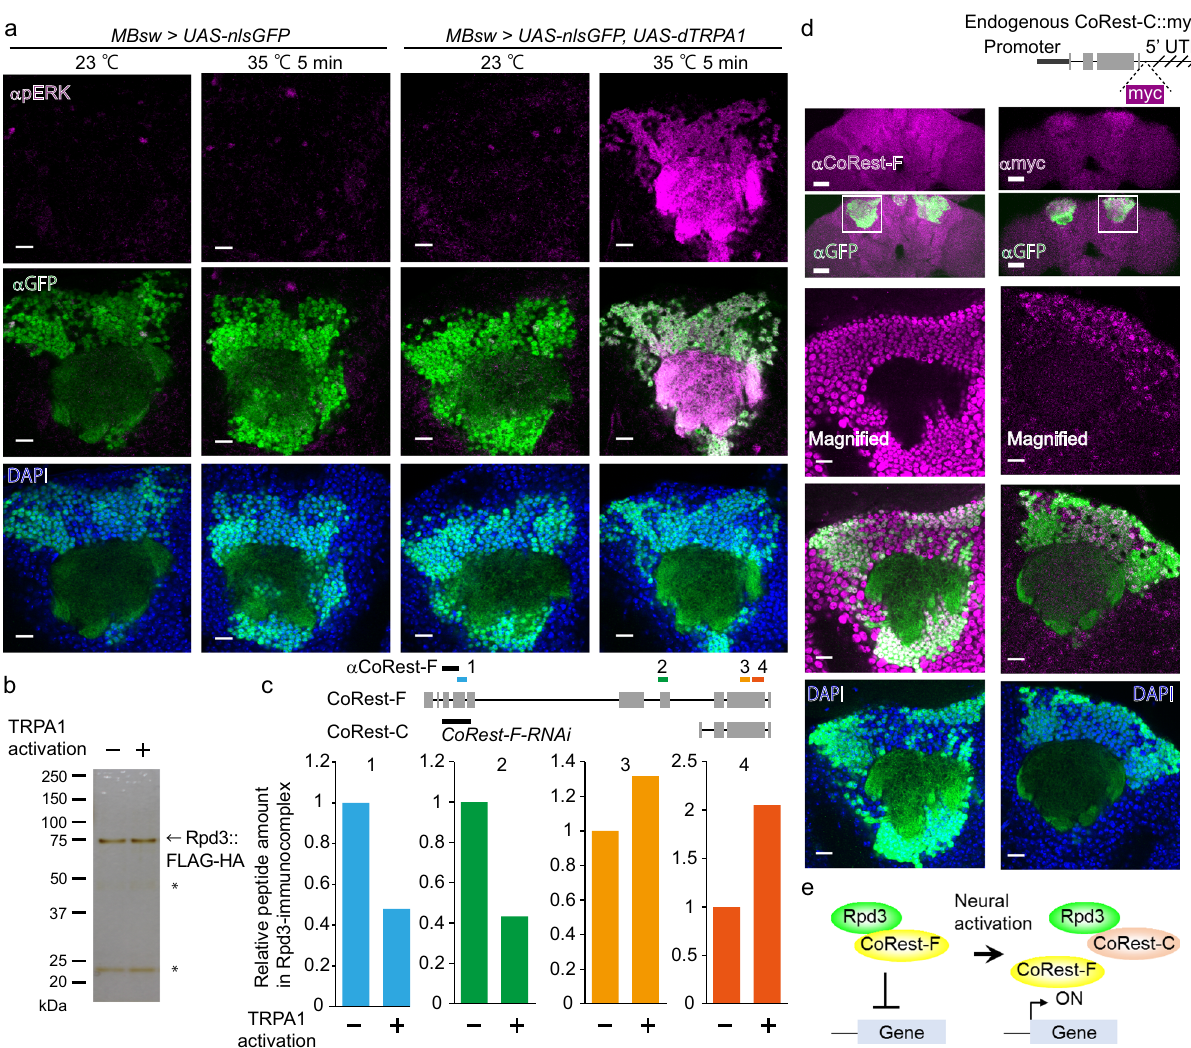
Fig. 1 Interactome analysis of Rpd3 in MB neurons. a Thermogenetic activation of MB neurons. GFP fused to the nuclear localization signal (nlsGFP) and dTRPA1 was induced in MB neurons using MBsw. The brains were immunostained with anti-GFP (green) and anti-pERK (magenta) antibodies, and DAPI (blue). The images are representative of experimental replicates ( n = 3, 4, 4, and 4). Scale bar: 10 μ m. b Puri fi ed Rpd3 proteins from MB neurons. Rpd3:: FLAG-HA was expressed by MBsw, together with dTRPA1. The fl ies were heat-shocked at 35 °C for 1 h, and the heads were used for tandem-tag af fi nity puri fi cation. The proteins were visualized by silver staining. Asterisks indicate the IgG heavy and light chains. c The amount of the representative CoRest peptides identi fi ed in the LC-MS/MS analysis. See more details in Supplementary Table 2. (Top) The vertical gray bars indicate the exons, and the horizontal lines indicate the region of the introns. The regions targeted by the anti-CoRest antibody and RNAi were indicated as black bars. d Expression of CoRest-F and CoRest-C. (Left) The fl ies expressing nlsGFP by MBsw were used to immunostain CoRest-F with the anti-CoRest antibody which detected the N-terminal domain of CoRest (magenta). (Right) The genomic region of CoRest-C was cloned, tagged with myc, and inserted into a different region of the genome. Flies also expressing nlsGFP by MBsw were immunostained with the anti-myc antibody (magenta). The images are representative of three experimental replicates. (Upper two panels) Scale bar: 10 μ m. (Lower three panels) Magni fi ed view depicted as white squares. Scale bar: 2 μ m. e Working hypothesis of the complex compositional change in Rpd3/CoRest. Source data are provided as a Source Data fi